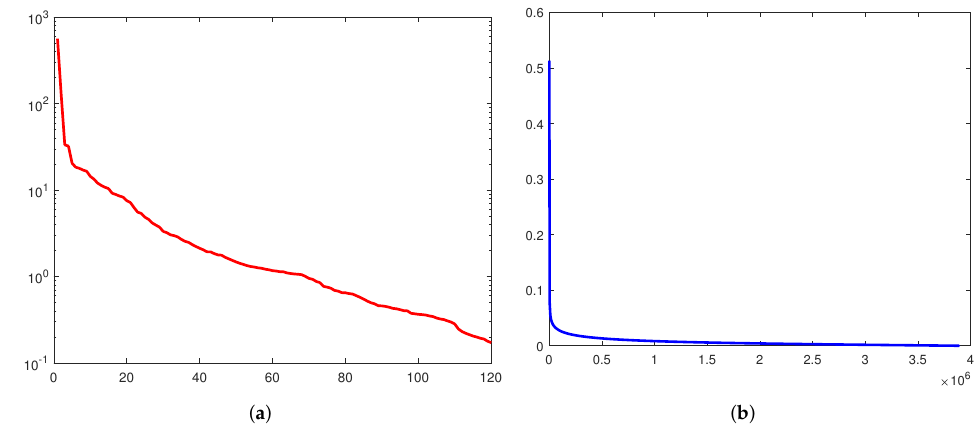
Figure 2. ( a ) Singular values of a low-rank item and ( b ) sparse item in hyperspectral